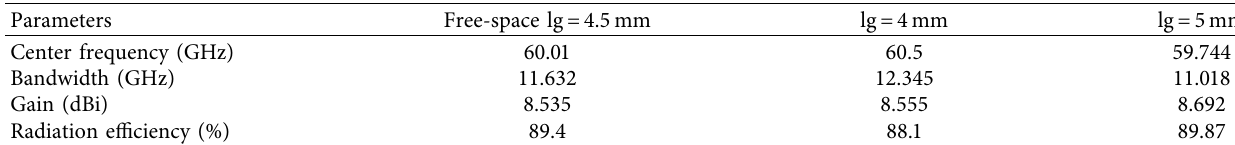
Table 5: Ground plane length changes.